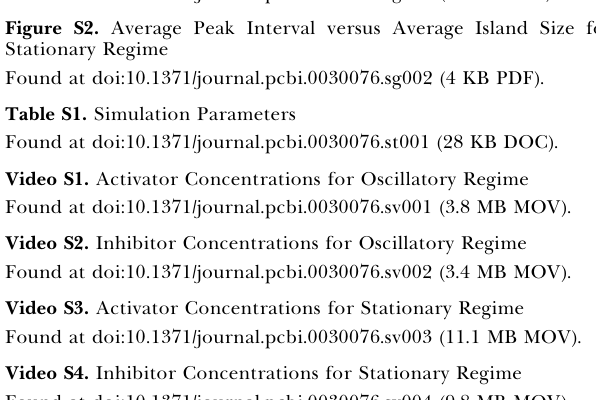
Figure S1. In Vitro and Stationary Regime Simulation Images for Spot-Like Precartilage Condensations Figure S2. Average Peak Interval versus Average Island Size for Stationary Regime Found at doi:10.1371/journal.pcbi.0030076.sg002 (4 KB PDF). Table S1. Simulation Parameters Found at doi:10.1371/journal.pcbi.0030076.st001 (28 KB DOC). Video S1. Activator Concentrations for Oscillatory